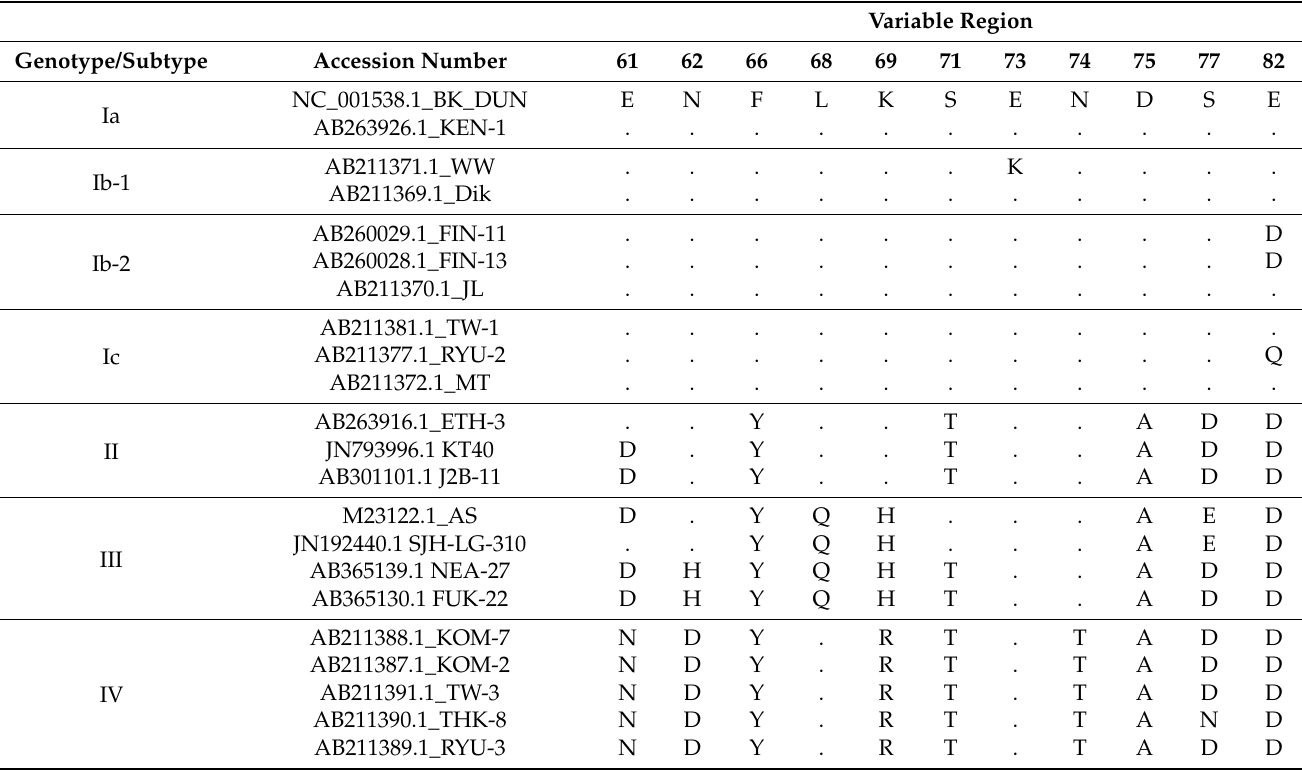
Table 1. Variable region in VP1 protein of BKPyV ranging from 61aa to 82aa (amino acids).